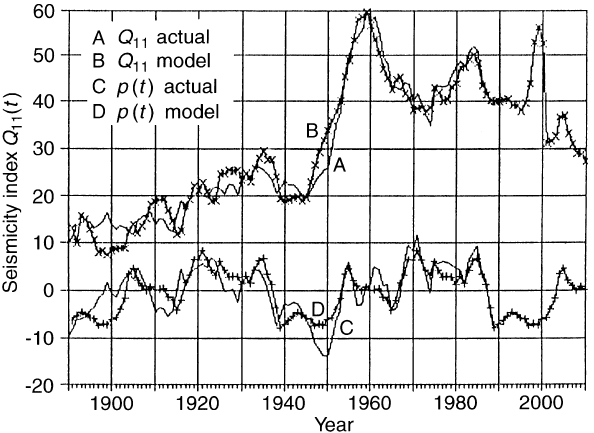
Fig. 10. Seismicity index model and residual